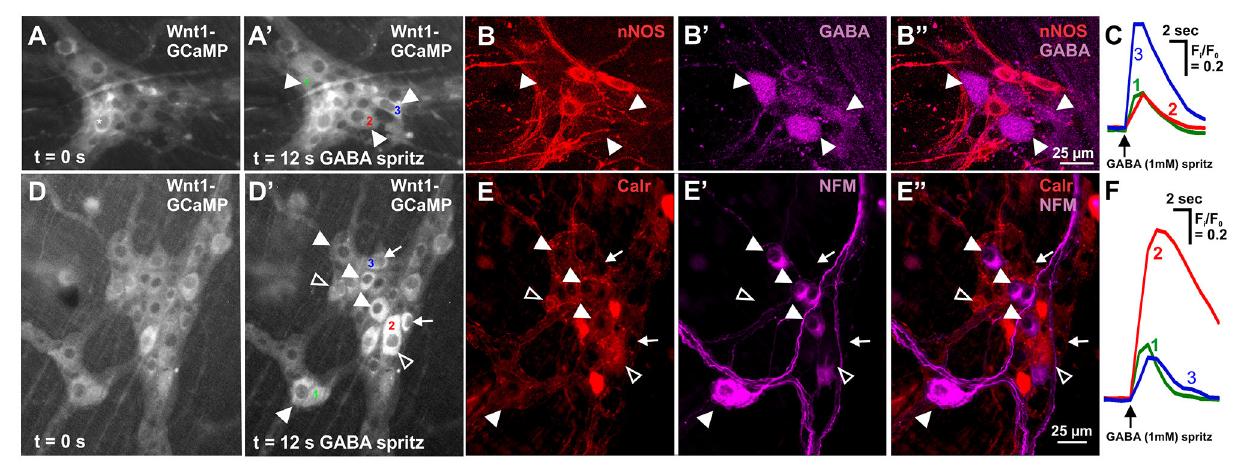
FIGURE 2 | Neurochemistry of neurons in the mouse ileum that displayed GABA evoked [Ca 2 + ] i transients. (A) Representative fluorescence micrographs of the GABA (1mM) evoked [Ca 2 + ] i response in myenteric neurons [GCaMP3 signal at rest ( A , t = 0); and during GABA stimulation ( A’ , t = 12s)]. (A’) In this ganglion, 3 neurons responded to GABA with a sharp increase in [Ca 2 + ] i (responsive neurons marked 1–3). (B) Confocal micrographs of the myenteric ganglion showing the neurons that responded to GABA (A’) were immunoreactive for GABA (filled arrowheads) and not nNOS. (C) Example traces from the 3 neurons (marked in A’ ) that responded to GABA. (D) Representative fluorescence micrographs of the GABA (1mM) evoked [Ca 2 + ] i response in myenteric neurons [GCaMP3 signal at rest ( D , t = 0); and during GABA stimulation ( D’ , t = 12s)]. (D’) In this ganglion, many neurons responded to GABA with a sharp increase in [Ca 2 + ] i (some marked with arrowheads and arrows, selected responsive neurons marked 1–3). (E) Confocal micrographs of the myenteric ganglion showing the neurons that responded to GABA (D’) were immunoreactive for NFM (filled arrowheads), Calretinin (open arrowheads) or neither NFM or Calretinin (arrows). (F) Example traces from the selected 3 neurons (marked in D’ ) that responded to GABA.